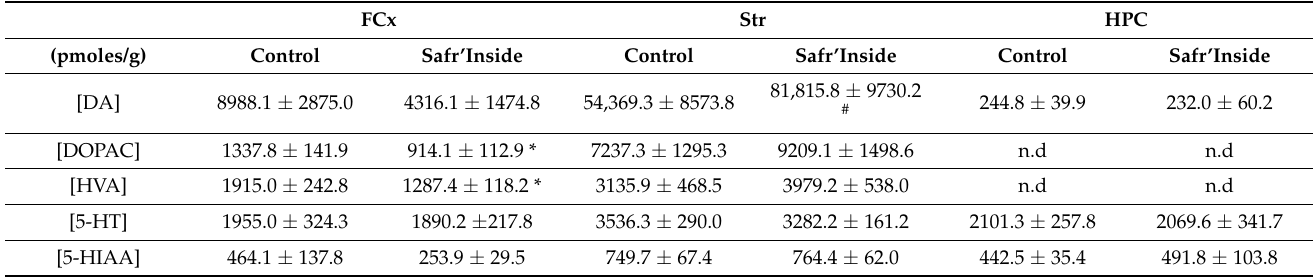
Table 1. Effect of chronic oral administration of Safr’Inside TM (6.25 mg/Kg) on monoamines levels measured by HPLC in the FCx, Str and HPC.